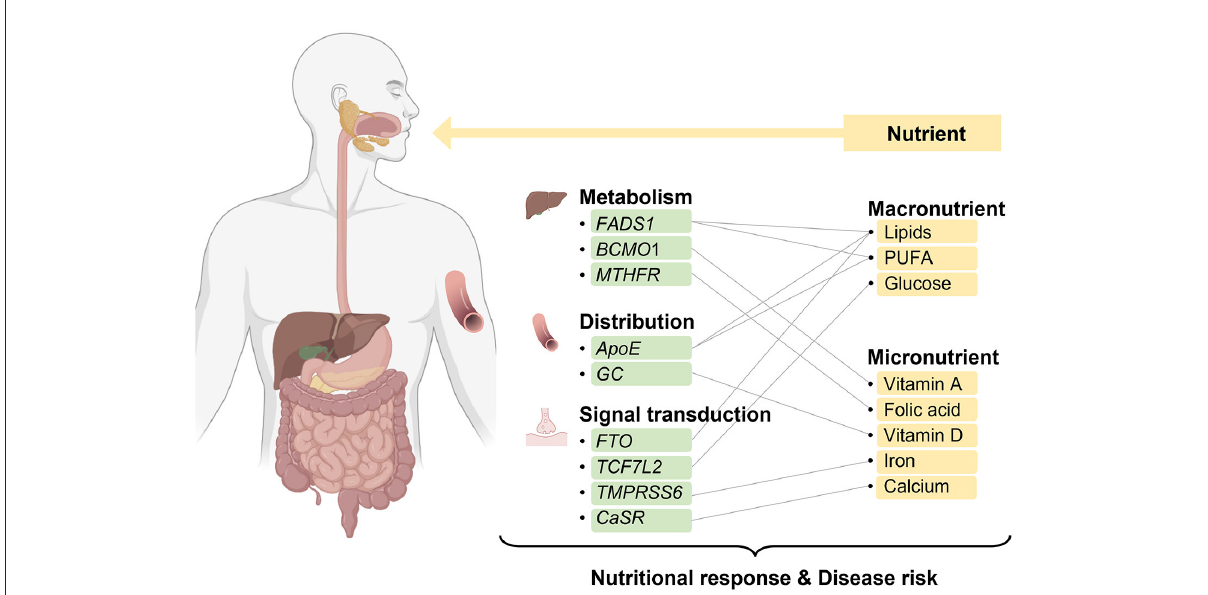
FIGURE1 Overview of interactions of nutrients and genes involved in the nutritional metabolism, distribution, and signal transduction. Created with BioRender.com.